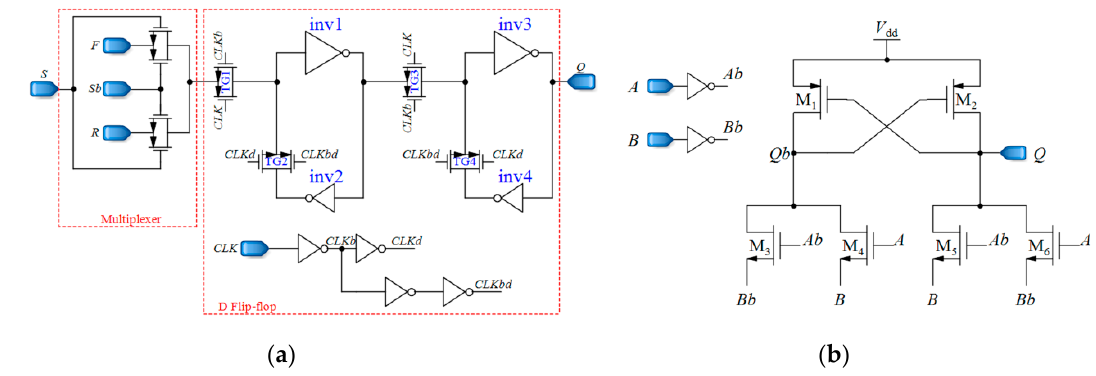
Figure 12. ( a ) Fast static D flip-flop, ( b ) Fast XOR gates based on a differential cascade voltage switch with a pass-gate (DCVSPG) [78].